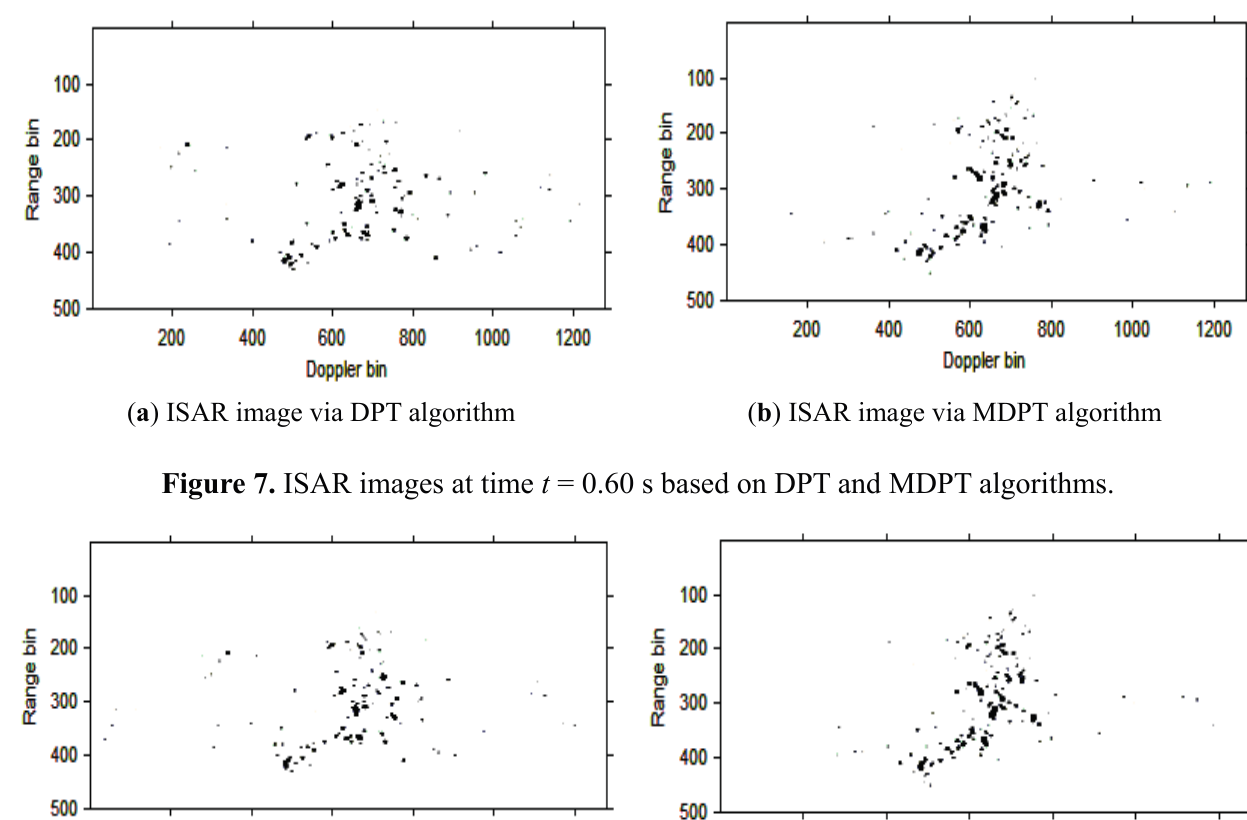
Figure 6. ISAR images at time t = 0.30 s based on DPT and MDPT algorithms. Then, the instantaneous ISAR images at times t = 0.60 s, t = 0.90 s, t = 1.20 s, t = 1.51 s and t = 1.81 s based on DPT and MDPT algorithms are shown in Figures 7 – 11, respectively.